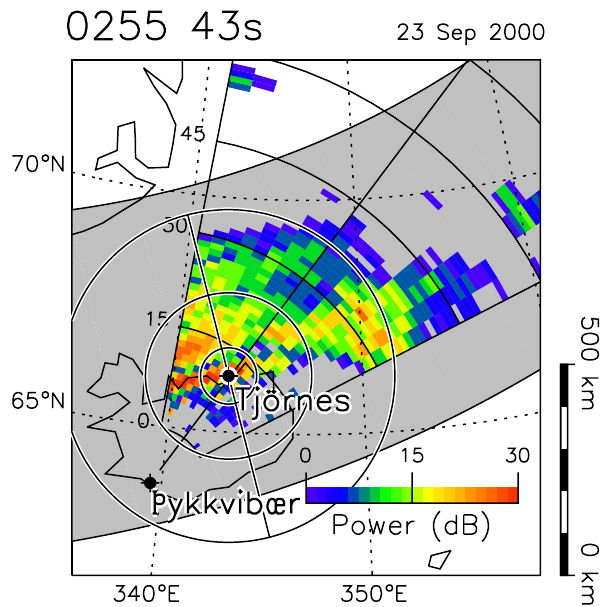
Fig. 1. A map showing the vicinity of Iceland and southeastern Greenland, indicating the location of the Pykkvibær radar and the Tj¨ornes all-sky camera. The radar field-of-view is mapped assum- ing a backscatter altitude of 110km. Colour-coded is the backscat- ter power from the radar scan starting 02:55:43UT on 23 September 2000. The projection of the ASC field-of-view is shown, with the three concentric circles marking the locii of zenith angles of 30 ◦ , 60 ◦ and 75 ◦ mapped to an altitude of 110km. The geomagnetic meridian employed to produce keograms is also shown. Superim- posed is the statistical auroral